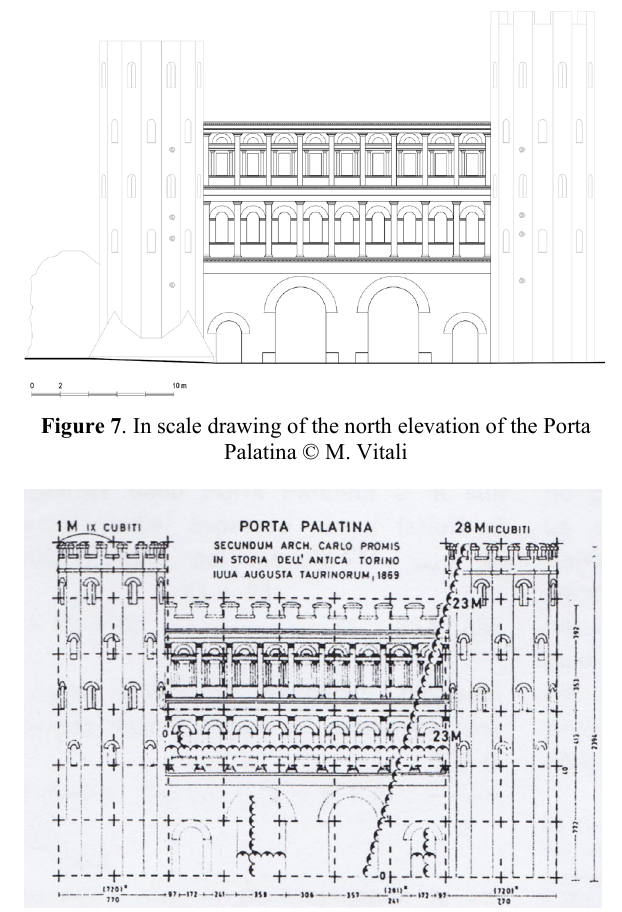
Figure 8 . Graphic analysis by Kurent, excerpt (Kurent 1965) A previous investigation focused on the graphic analysis and the representation of the north elevation based on the units of